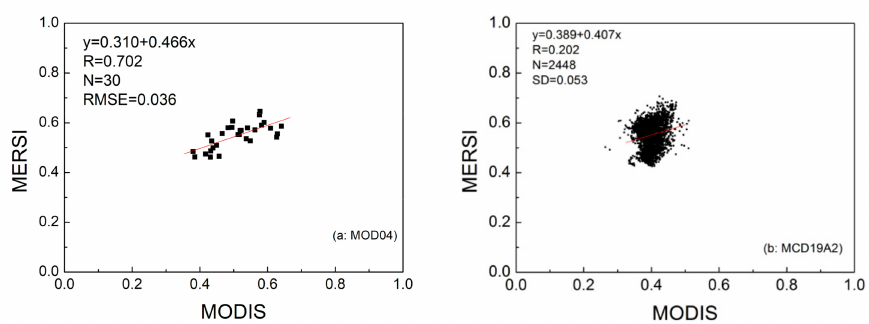
Figure 13. Scatter plot of moderate-resolution imaging spectroradiometer (MODIS) ( a ): MOD04. ( b ): (MCD19A2) and Medium Resolution Spectral Image (MERSI)